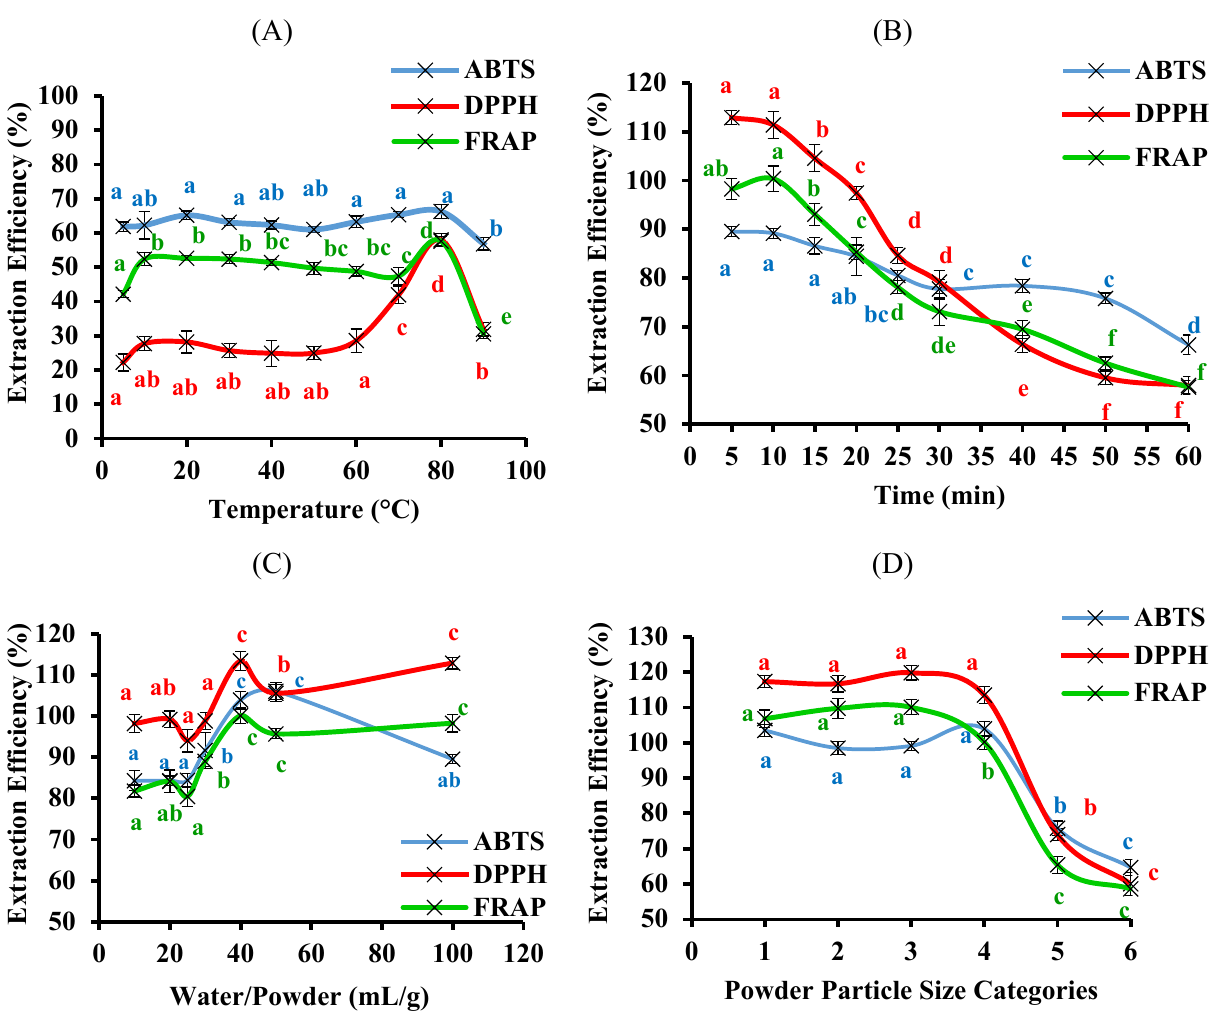
Figure 5. The extraction efficiency for antioxidant capacity from bitter melon using water. The aqueous extraction was optimised using one-variable-at-a-time method and each variable was tested in sequential order: ( A ) temperature; ( B ) time; ( C ) water-to-powder ratio; ( D ) powder particle size and ( E ) number of times the same sample is extracted. The powder particle size categories were: (1) <0.25, (2) 0.25–0.05, (3) 0.5–1.0, (4) 1.0–2.0, (5) 2.0–2.8 and (6) >2.8 mm. The extraction efficiency was relative to the 80% ethanol extract and data are means ± standard deviations ( n = 3) and those not sharing a letter are significantly different ( p < 0.05) from each